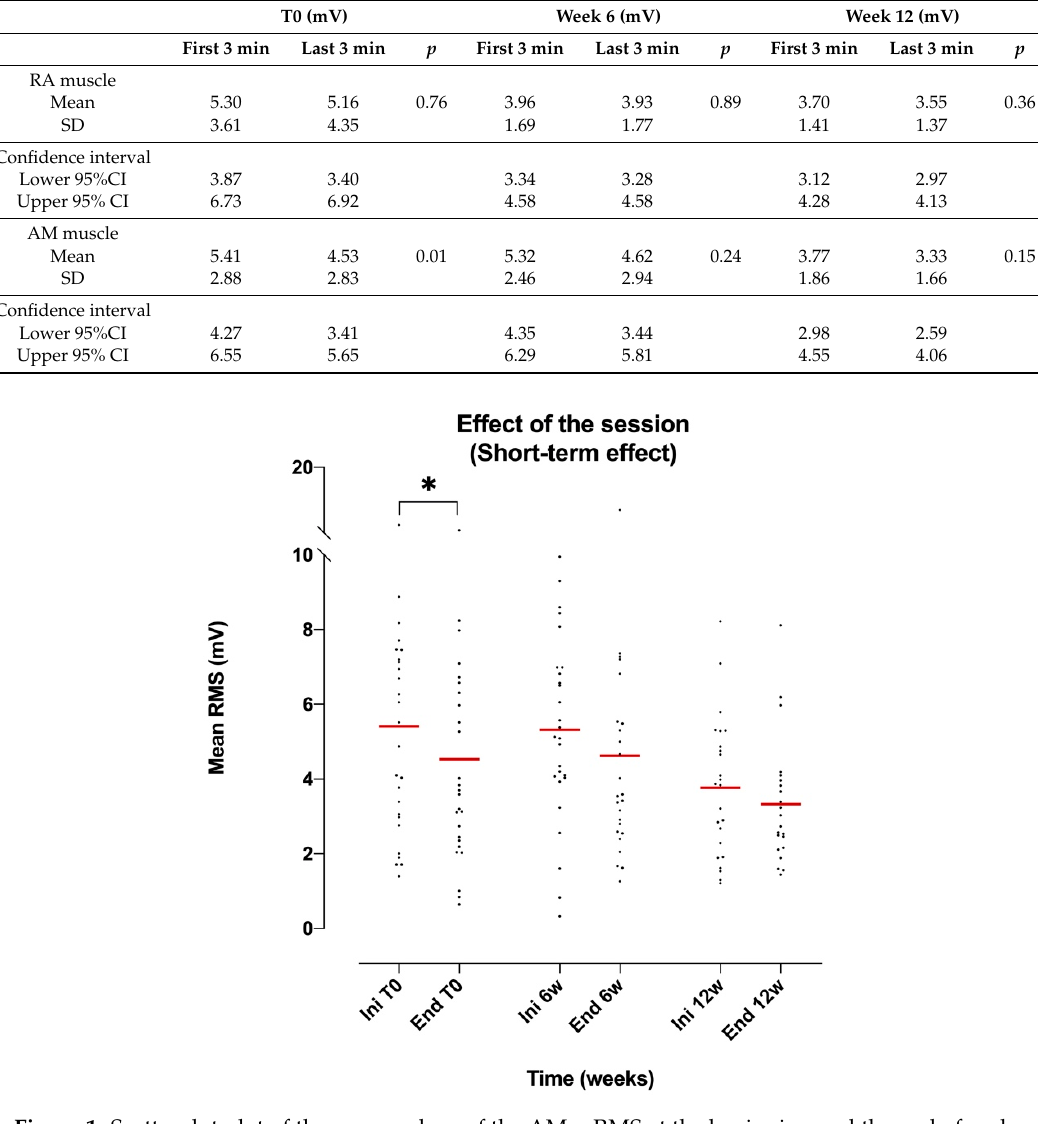
Figure 1. Scatter dot plot of the mean values of the AM mRMS at the beginning and the end of each / End) regardless of treatment time. Tukey multiple-comparison test: * ( p < session (Ini/End) regardless of treatment time. Tukey multiple-comparison test: * ( p < 0.05). session (Ini